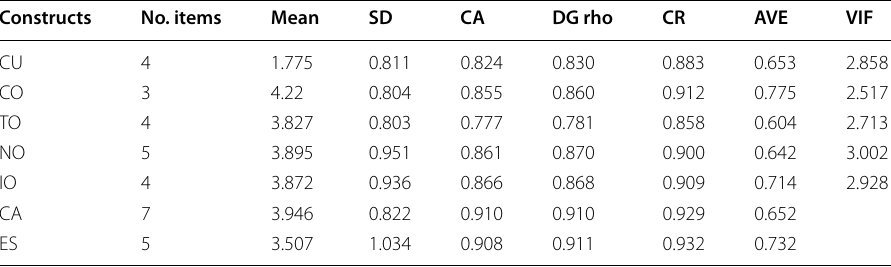
CU customer orientation, CO competitor orientation, TO technology orientation, NO network orientation, IO innovation orientation, CA competitive advantage, ES economic sustainability, DG’s rho Dillon–Goldstein’s rho, SD standard deviation, CA Cronbach’s alpha, CR composite reliability, AVE average variance extracted, VIF variance inflation